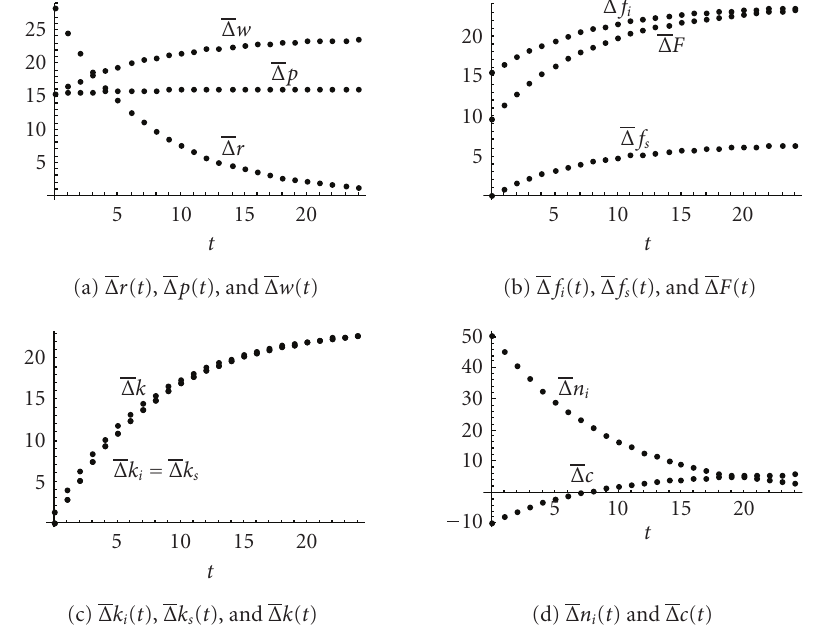
Figure 5.1. An improvement in the capital good sector’s productivity.